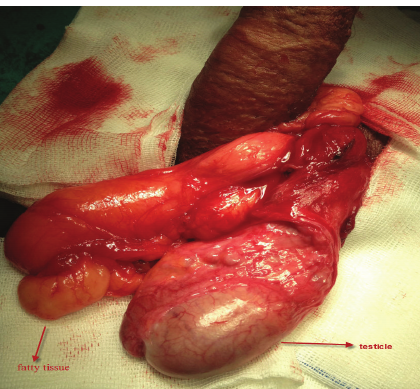
Figure 1: Observed fatty tissue beginning from the outlet of the inguinal channel and outside testicle into the scrotum in operative image.